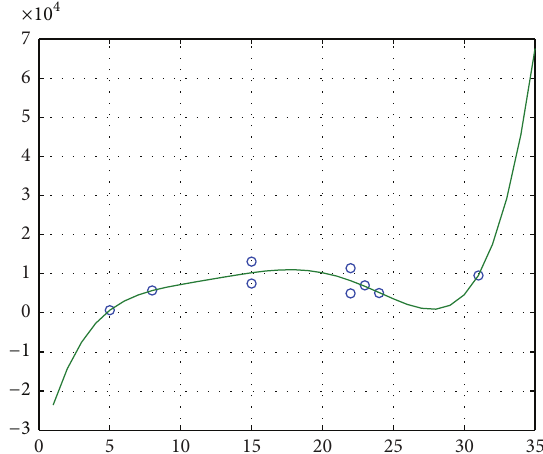
Figure 4: Number of leaf nodes and fuzzy